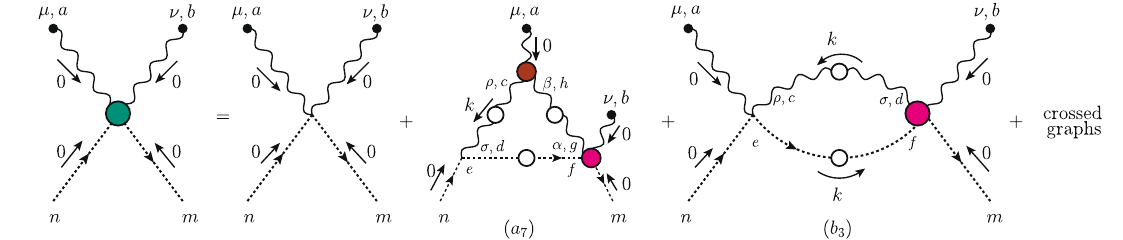
Fig. 6 The diagrammatic representation of the SDE for the BB ¯ ccin the all-soft